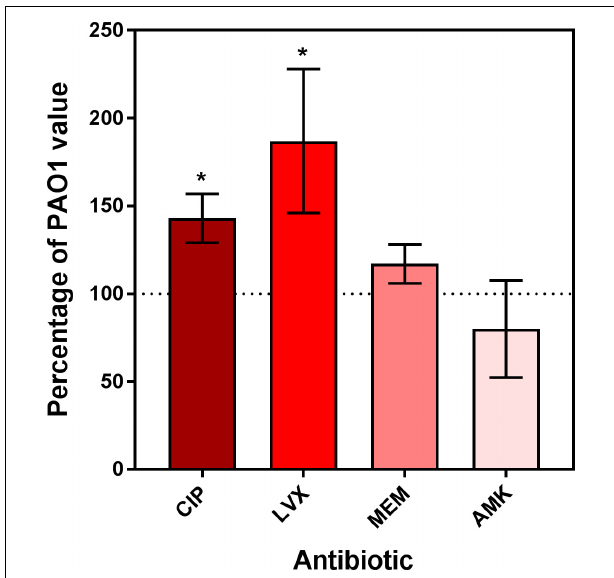
FIGURE 4 | Relative fraction of intraphagocytic dnpA insertion mutant as compared to PAO1 showing less than 10 3 . 5 of GFP fluorescence after 24 h of incubation with antibiotics at a concentration corresponding to 50x MIC. The horizontal dotted line corresponds to the reference value (PAO1). Data are the mean ± SEM of at least 3 experiments performed in triplicates. Statistical analysis (multiple t -test) comparing dnpA ::Tn to PAO1: ∗ p < 0.05 and ∗∗ p < 0.01. CIP, ciprofloxacin; LVX, levofloxacin, MEM, meropenem, AMK,